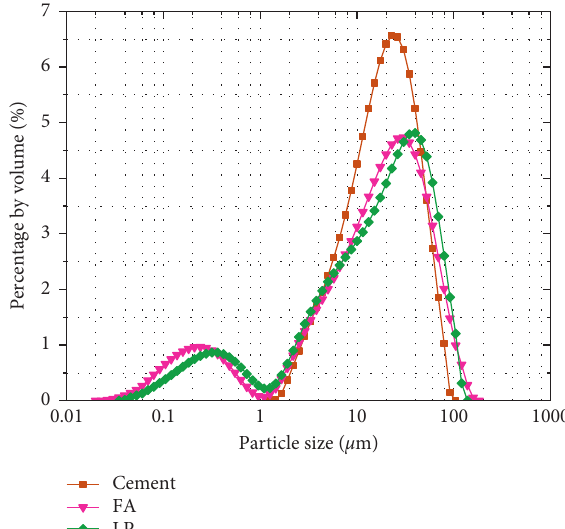
Figure 2: Particle size distribution curves of cement, FA, and